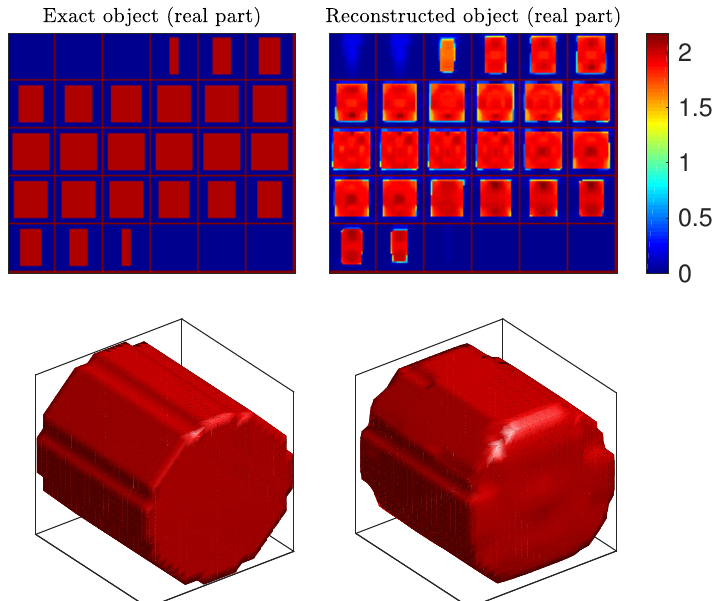
Figure 5. Reconstructed contrast function for the Cylinder object. Top: 30 horizontal slices of the true object ( left ) and the 30 slices of the reconstructed object ( right ). Bottom: isosurfaces of the true object discretized on the reconstruction grid ( left ), and of the reconstructed object ( right ), for contrast value